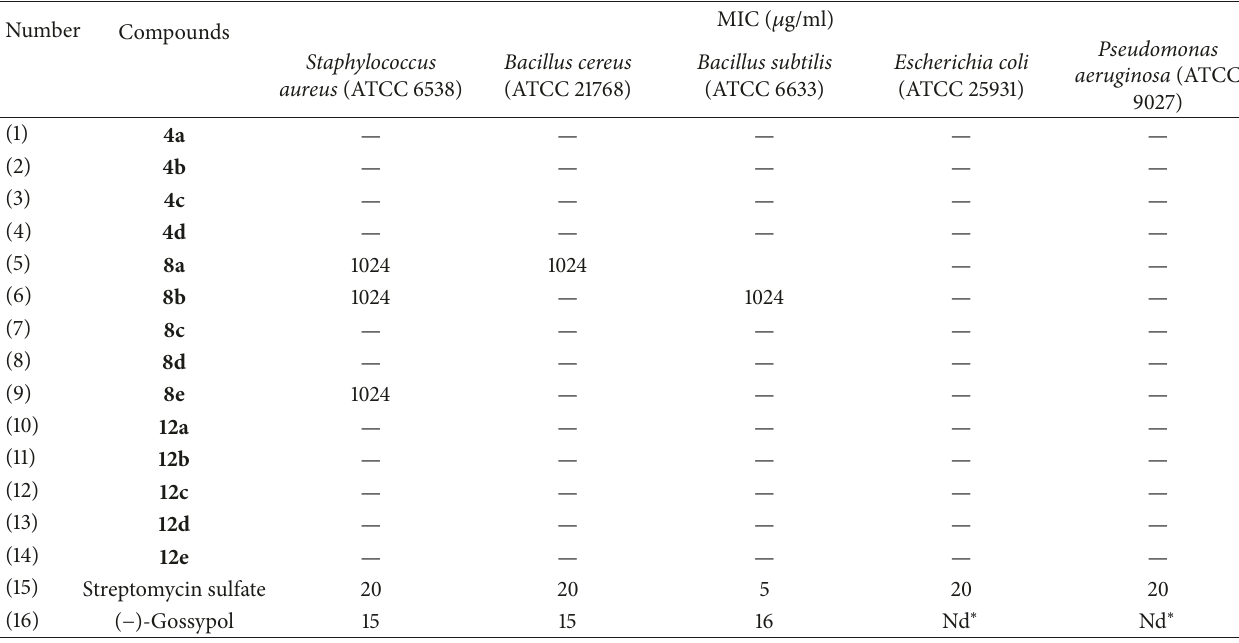
Table 2: Antibacterial activity of compounds against human pathogenic